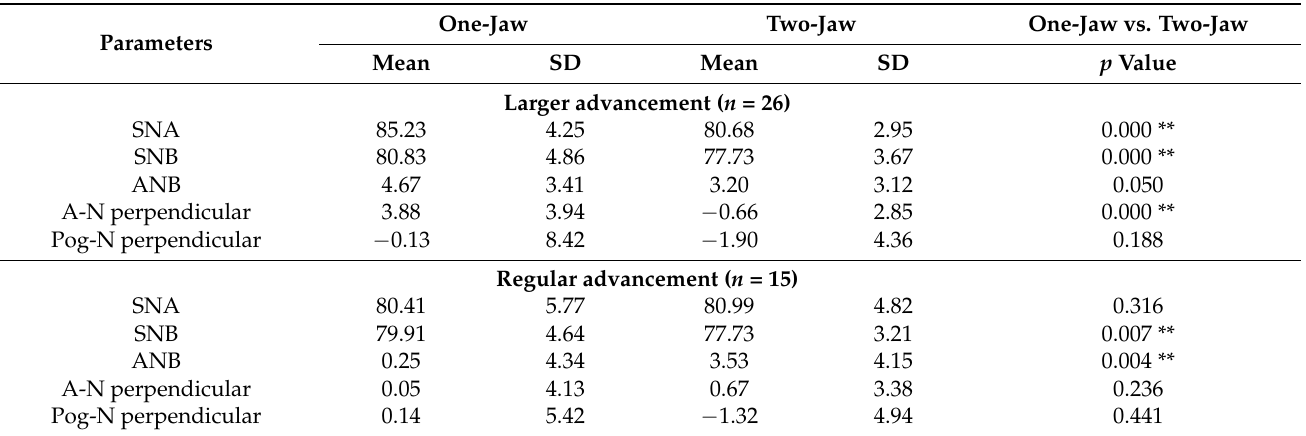
Table 4. The 3D cephalometric measurements in the larger (more than 6 mm) and regular (6 mm or less) advancement designs.